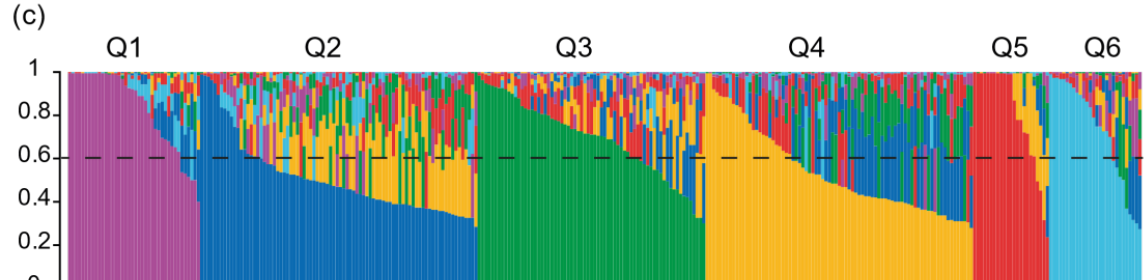
Figure 3. Population structure of the IAS pea core collection as estimated by STRUCTURE. ( a ) Esti- mating the optimum subpopulation number was based on Evanno ‘s parameter (ΔK). ( b ) STRUC- TURE output for K = 3. ( c ) STRUCTURE output for K = 6. Each bar of the histograms represents the percentage of membership to each STRUCTURE subpopulation of a given pea accession from the IAS pea core collection.